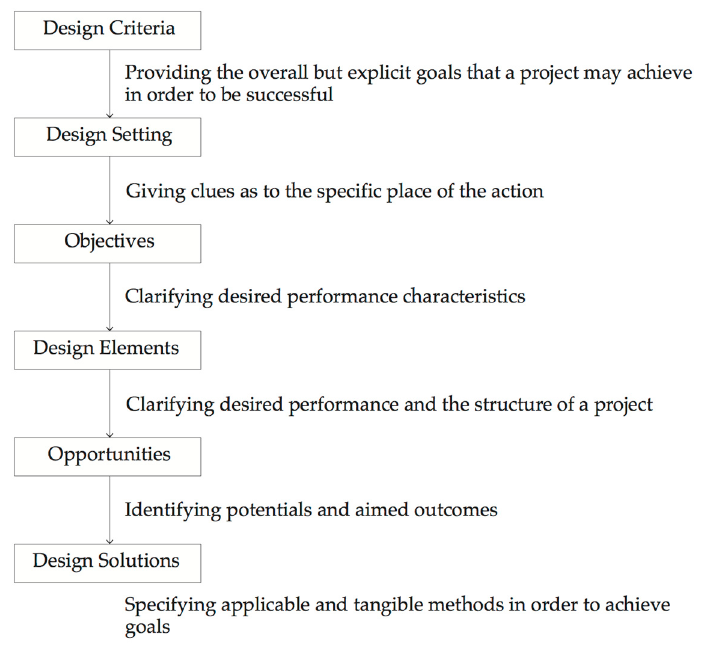
Figure 3. Environmental Experience Design ( EXD) matrix evaluation process for human-environment element integration.